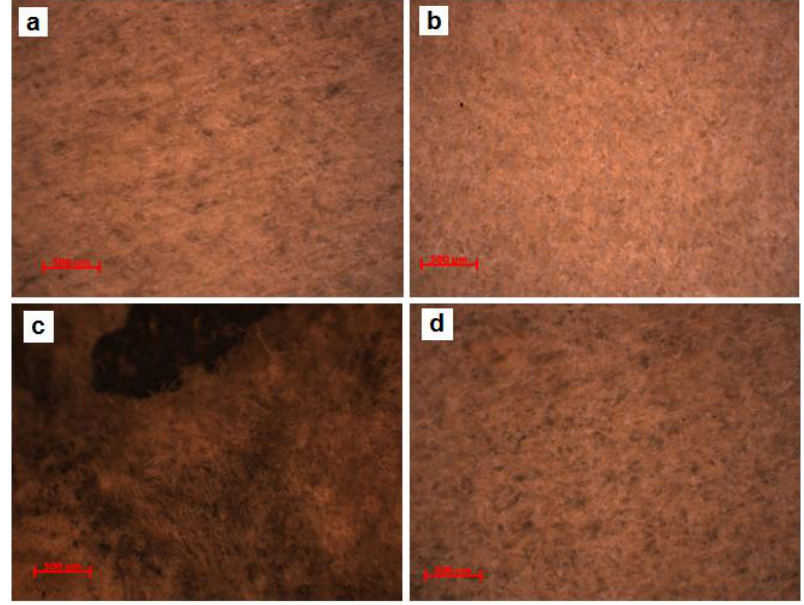
Figure 3. Optical microscopy (OM) images ( × 50) of document S1: ( a ) marginal area (S1-SD1); ( b ) between the rows of writing (S1-SD2); ( c ) the binding area of the support (S1-SD2); and ( d ) the back of the document.